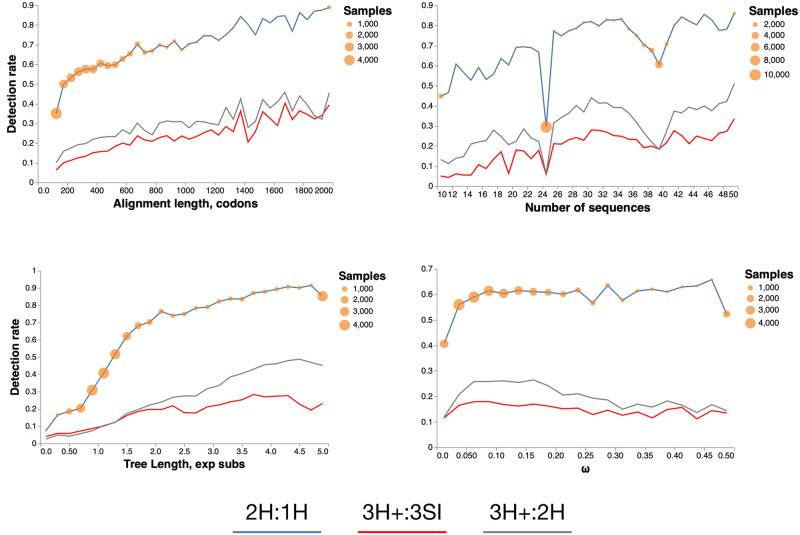
Multiple hit detection rate.The fraction of alignments where the corresponding test was significant at p ≤ 0.01 as a function of one of four alignment properties. Orange circles depict the binning steps and the number of alignments falling into each bin. For tree lengths and ω values we used estimates under the 1H model.